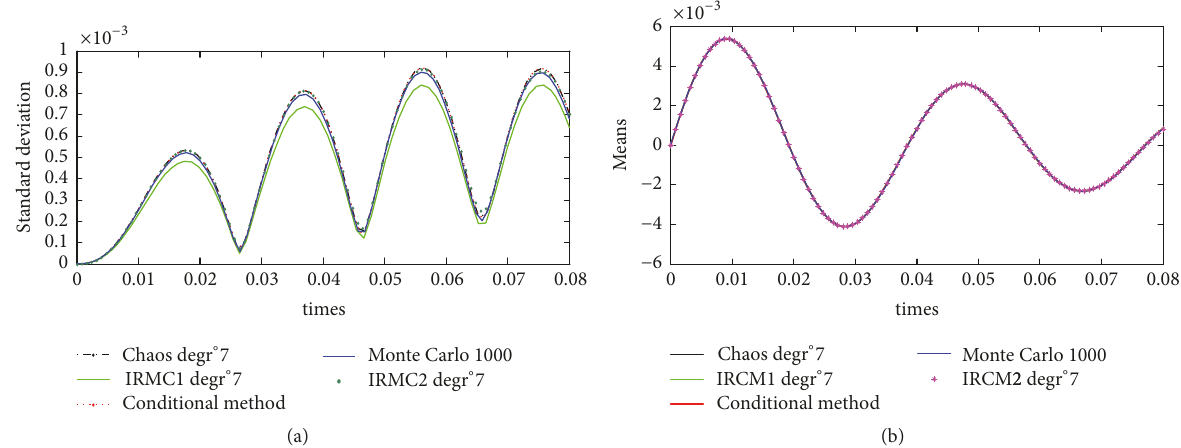
Figure 2: (a) Standard deviation of 𝑈 when 𝜉 𝑖 follow the uniform law in [−4, 4] and 𝜎 𝑖 = 5%. (b) Means of 𝑈 when 𝜉 𝑖 follow the uniform law in [−4,4] and 𝜎 𝑖 = 5%.